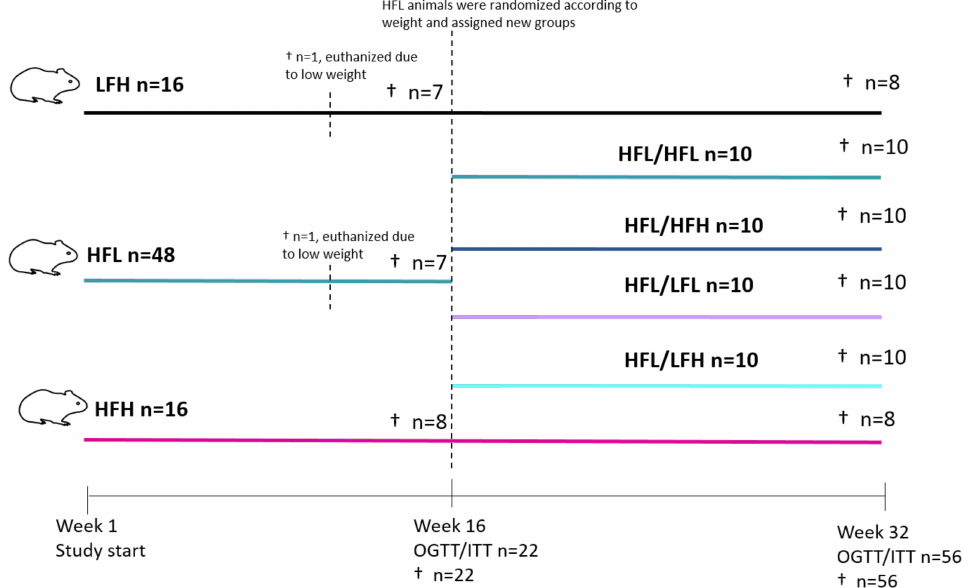
Figure 1. Study overview. Eighty guinea pigs were weight stratified into HFH, HFL, or LFH groups. One animal from each of the HFL and LFH groups was euthanized owing to weight loss. Following 16 weeks on diets, a subset were selected for OGTT/ITT and subsequent euthanization (HFL and LFH n = 7; HFH n = 8). The remaining animals in LFH and HFH groups continued on diets, whereas those in the HFL group ( n = 40) were weight stratified into HFL/HFL, HFL/HFH, HFL/LFL,